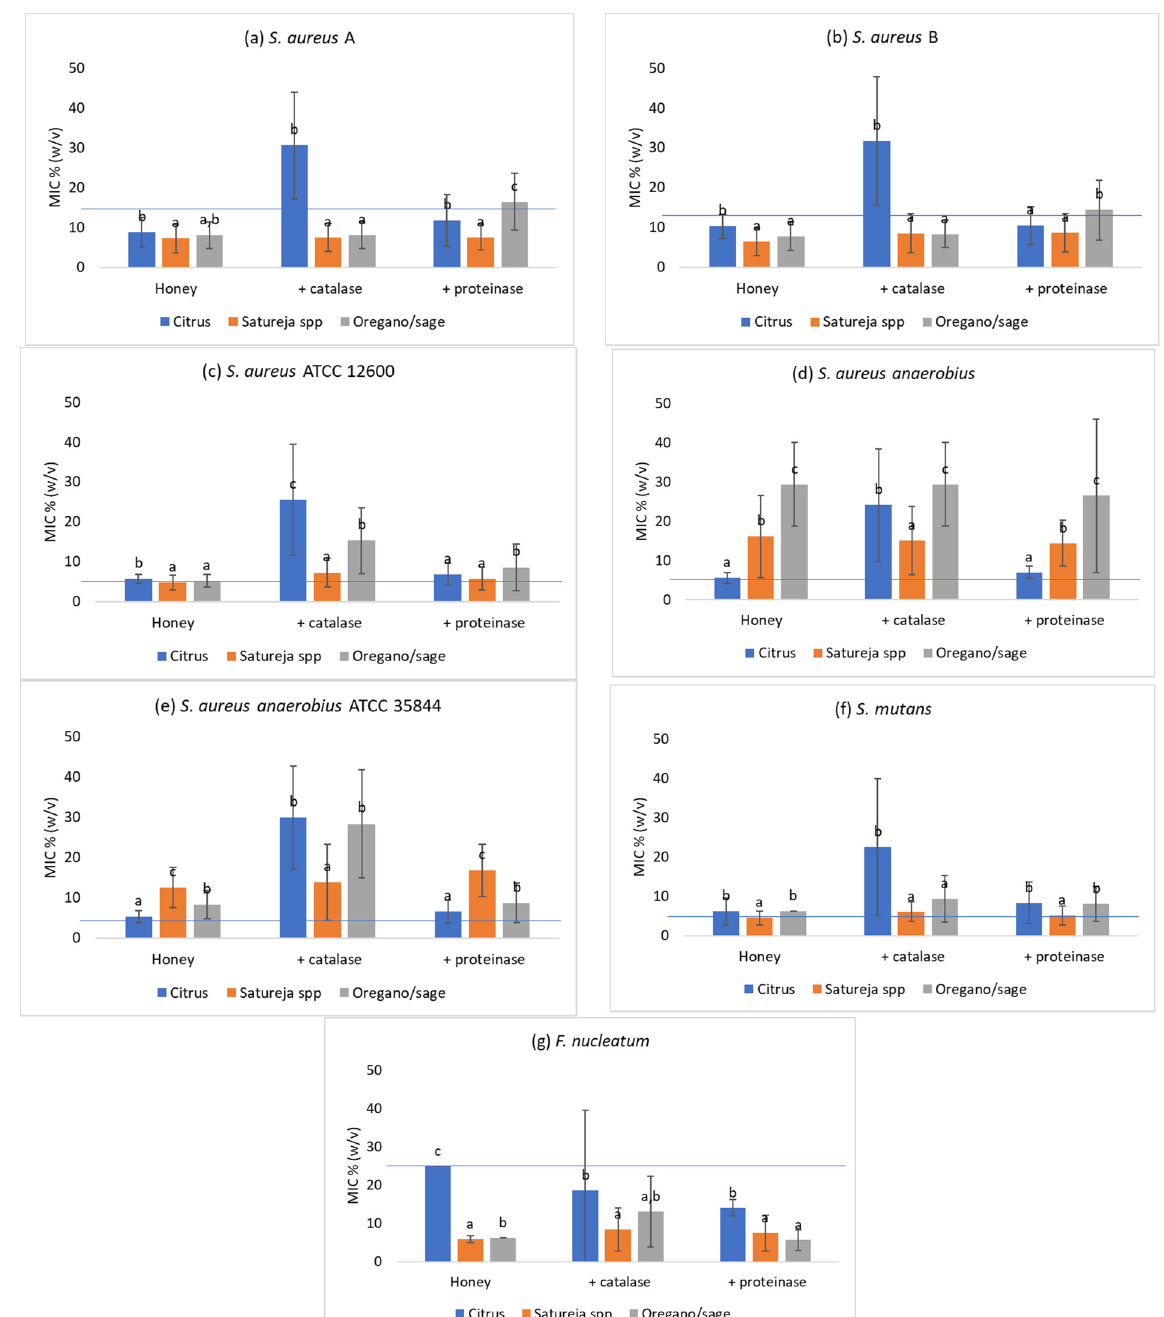
Figure 2. ( a – g ): Minimum inhibitory concentration of local ( n = 60) honey samples treated with and without catalase or proteinase, as well as manuka honey ( n = 1) against seven oral pathogens. Different letters indicate differences among the types of honey within each treatment. Line (blue) indicates the MIC value of manuka.